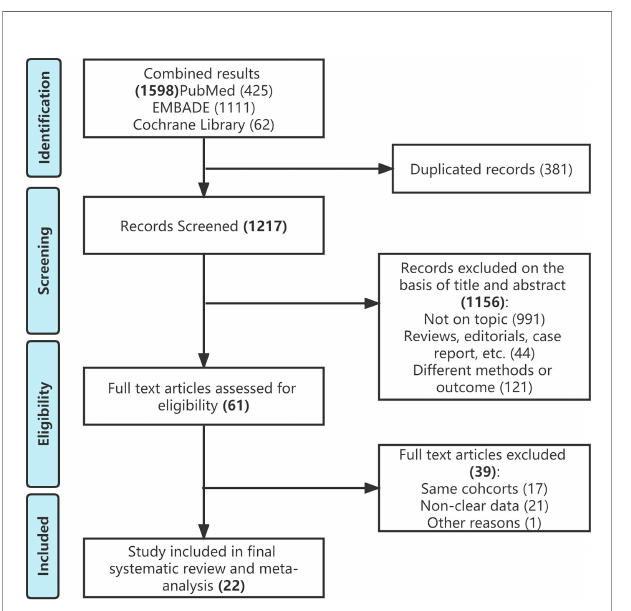
FIGURE 2 | Forest plots of studies investigating the association of neoadjuvant chemotherapy with survival outcomes in variant histology. MP, micropapillary; SQ, squamous; GL, glandular; NE, neuroendocrine; SA, sarcomatoid; NR, not